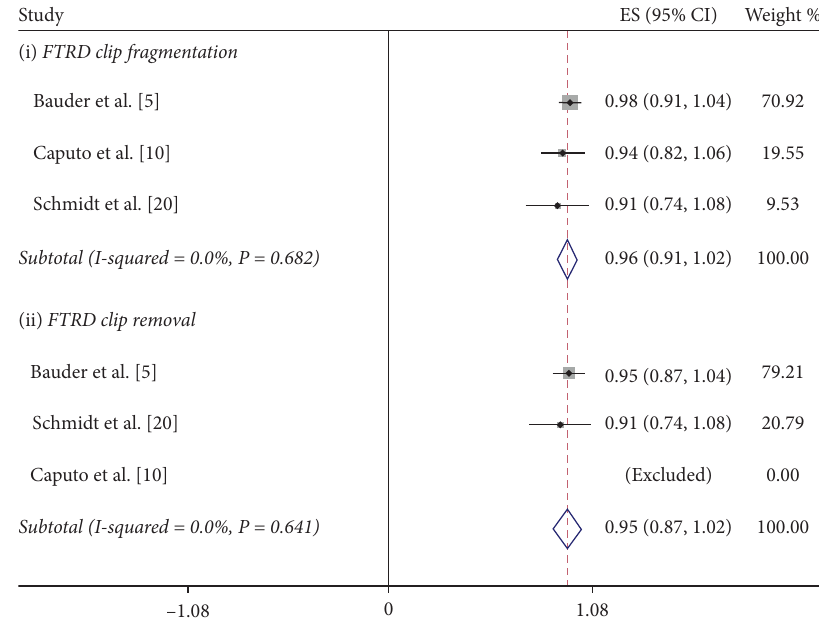
Figure 6: The subgroup analysis of success rate for FTRD clip removal by the remOVE system.